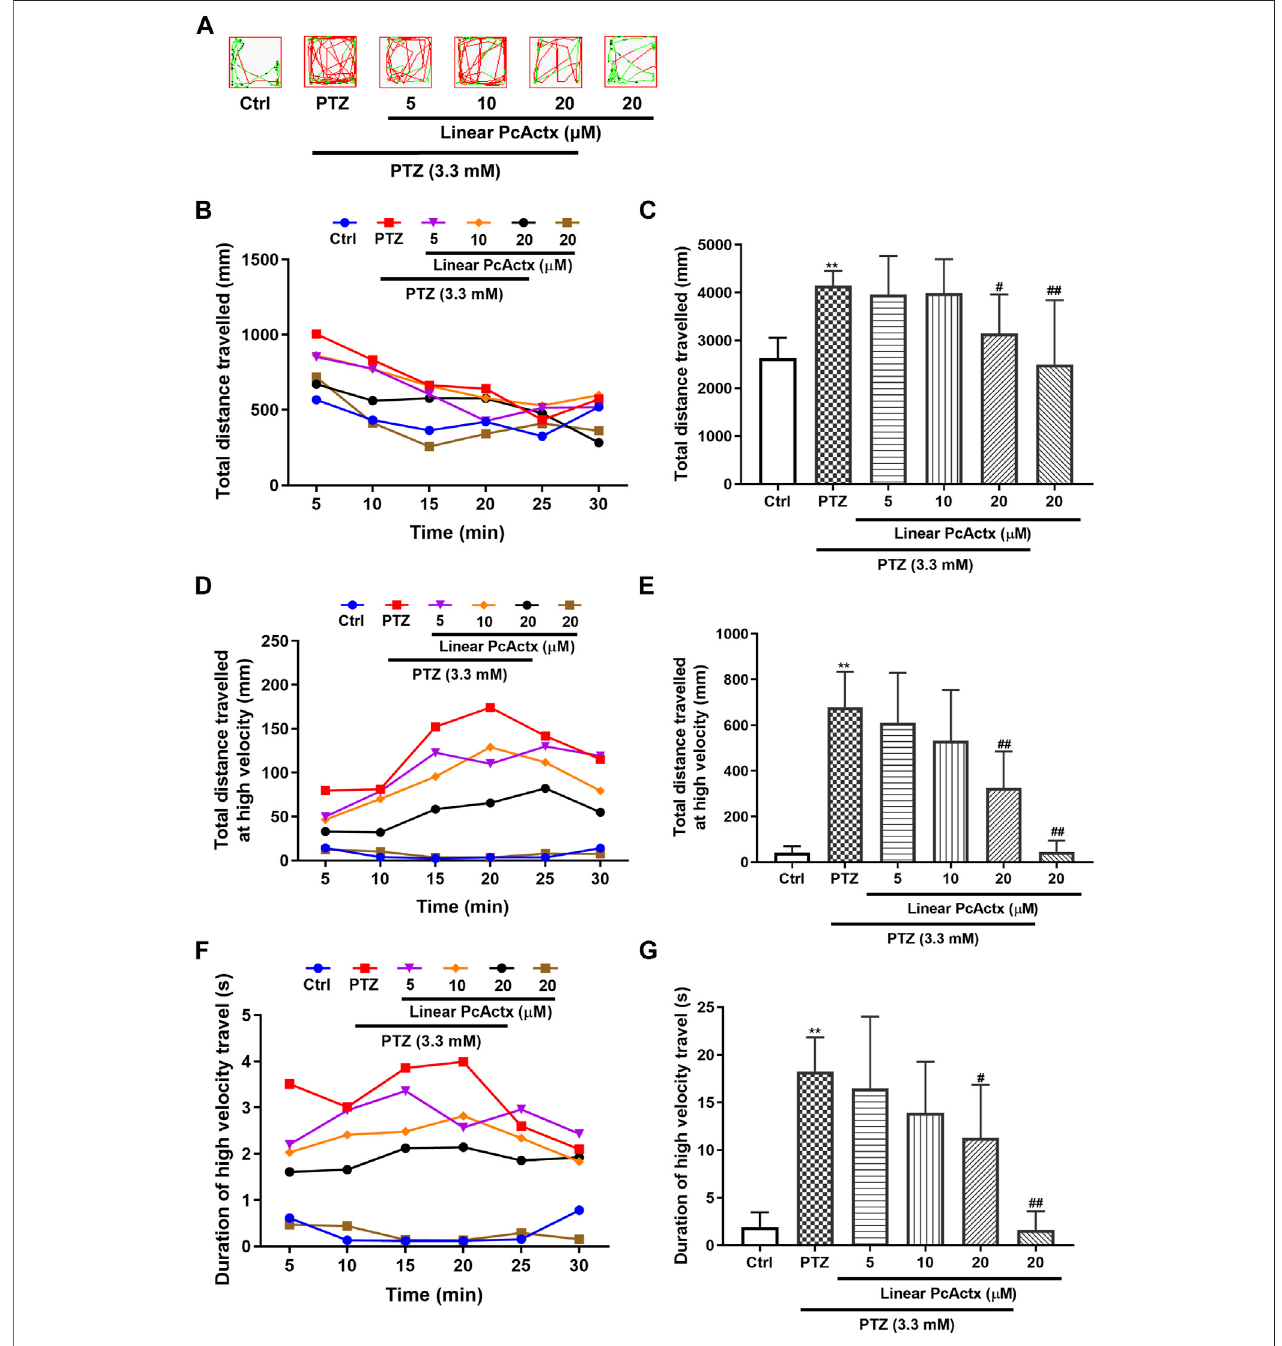
FIGURE 6 | Linear PcActx peptide alleviated PTZ-induced seizure-related behavior in zebra fi sh larvae. (A) Representative patterns of behavioral locomotion in zebra fi sh larvae. The swimming trajectory was recorded every 5 min and is represented by curves. The instantaneous velocity was detected and displayed in different colors (black, < 2 mm/s; green, 2 – 20 mm/s; red, > 20 mm/s). (B) . Changes in total distance travelled by period. (C) . Statistical analysis of total distance travelled. (D) . Changesintotaldistancetravelledathighvelocitybyperiod( > 20 cm/s). (E) .Statisticalanalysisoftotaldistancetravelledathighvelocity( > 20 cm/s). (F) .Changesin the durationof high velocity travel byperiod ( > 20 cm/s). (G) . Statistical analysisof theduration ofhigh velocity travel ( > 20 cm/s). Dataare expressed as means ± SD (n (cid:2) 9 – 10). * p < 0.05 vs Ctrl group, ** p < 0.01 vs Ctrl group, # p < 0.05 vs PTZ group, ## p < 0.01 vs PTZ group.